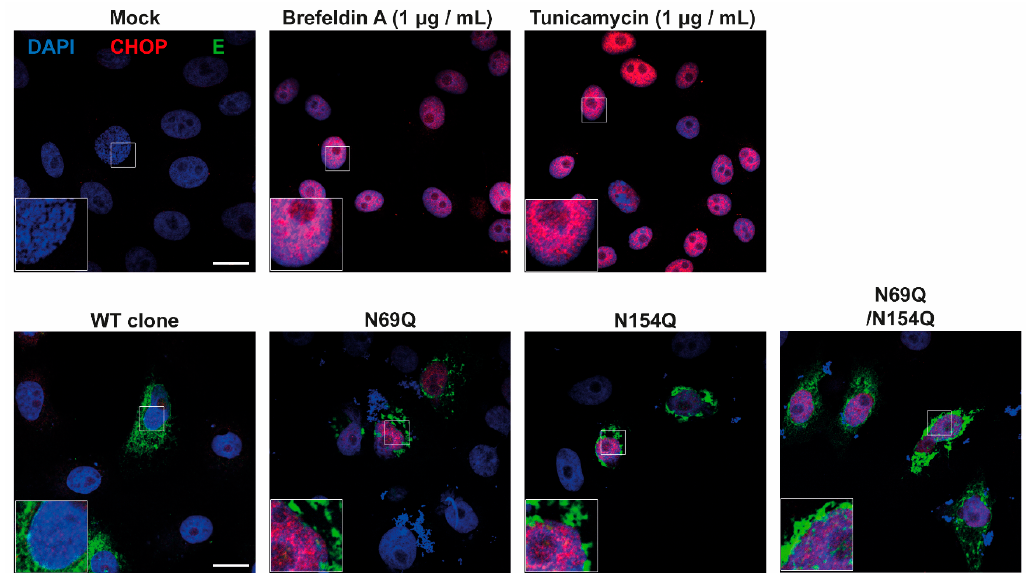
Figure 6. The lack of N-glycan on the prME protein induced ER stress. For the immunofluorescence assay, Vero cells were transfected with pcDNA3.1-prME plasmids for 48 h, samples were stained with a mouse anti-CHOP (CCAAT-enhancer-binding protein homologous protein) antibody together with a rabbit anti-ZIKV E antibody followed by secondary antibodies and DAPI. In positive controls, CHOP expression was induced with Brefeldin A (1 µg/mL) or Tunicamycin (1 µg/mL) for 24 h. Representative images of ZIKV E-CHOP double-stained Vero B4 cells. Scale bar = 20 µm.